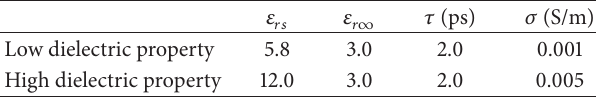
𝜀 𝜀 𝜏 (ps) 𝜎 (S/m) 𝑟𝑠 𝑟∞